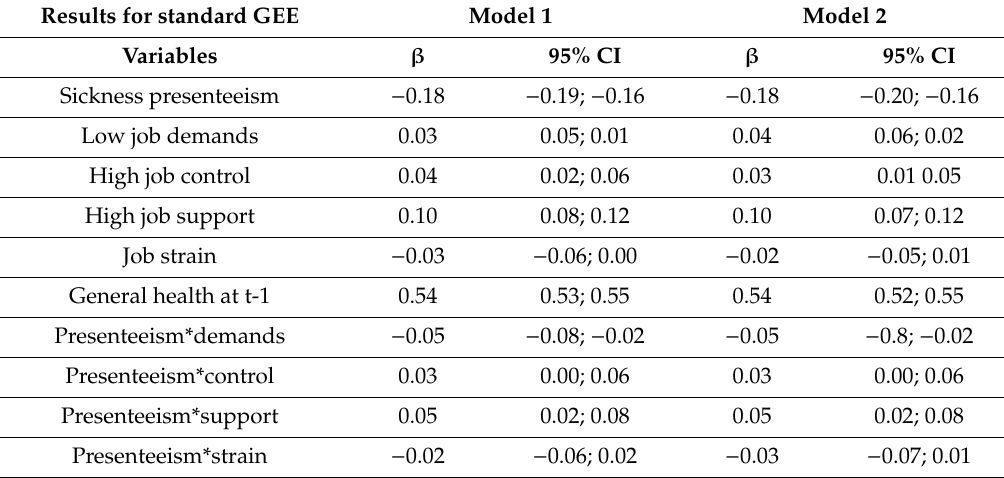
Table 4. Results of the autoregressive adjusted generalized estimating equation (GEE) analyses of the association between sickness presenteeism (1 = sickness presenteeism of ≥ 1 day during the past 12 months) and general health, presented as beta estimates ( β ) with 95% CIs, taking all possible moderating job characteristics into